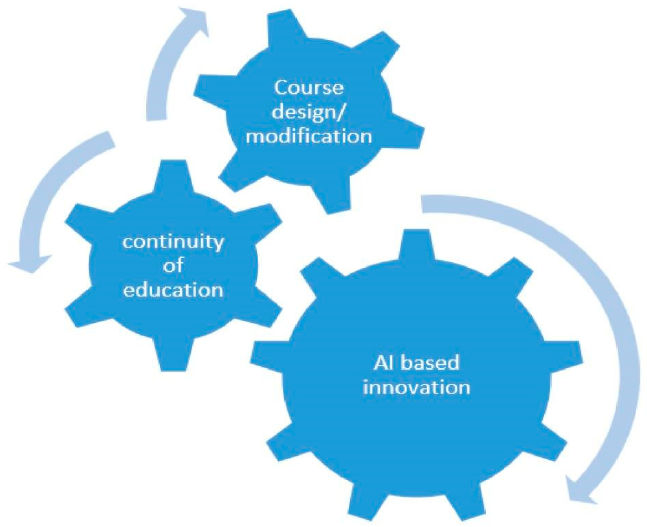
Figure 2. Road map of academia to face the challenges and create opportunities.